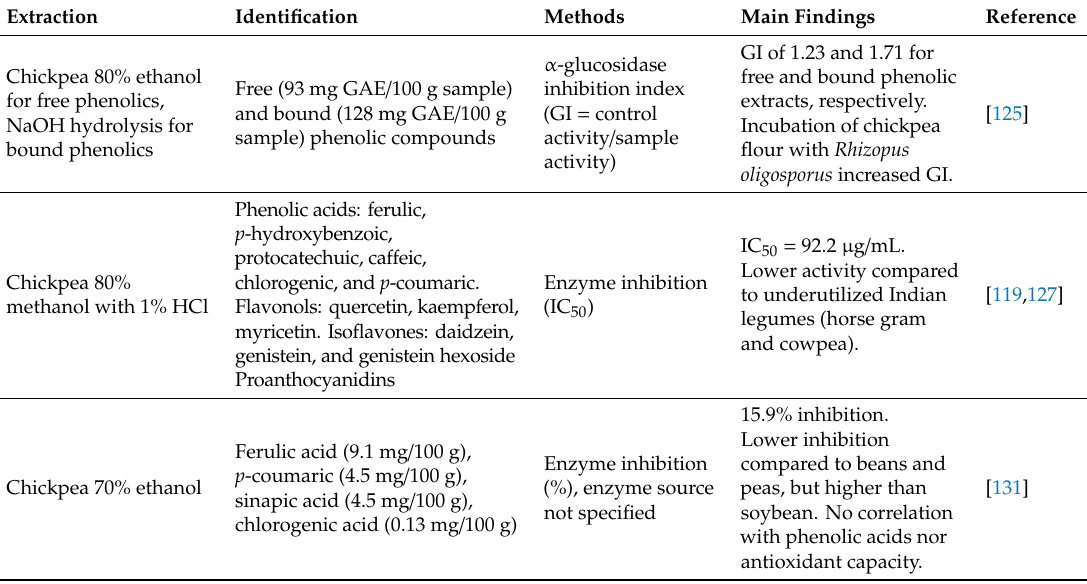
Table 5. Inhibition of α -glucosidase by soybean and chickpea phenolic extracts. Extraction